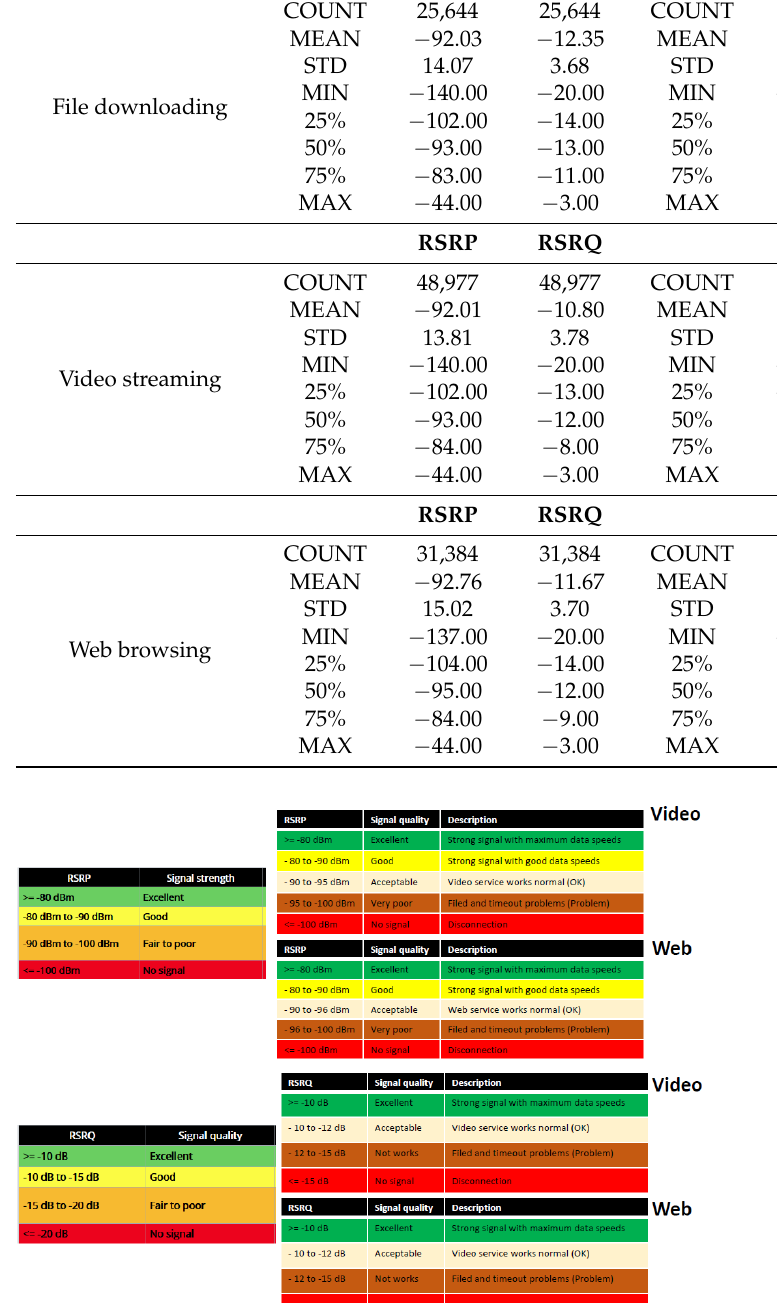
Figure 6. Recommended signal strength levels for web and video using all